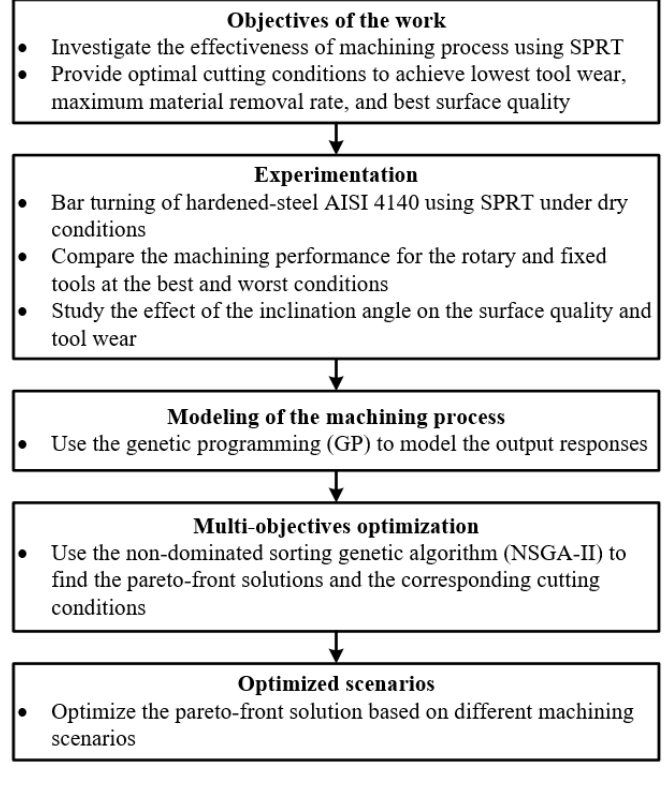
Figure 1. Flow chart for the research methodology.